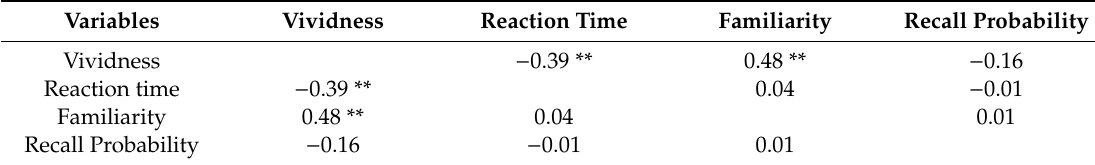
Table 2. Pearson Correlations between the experimental